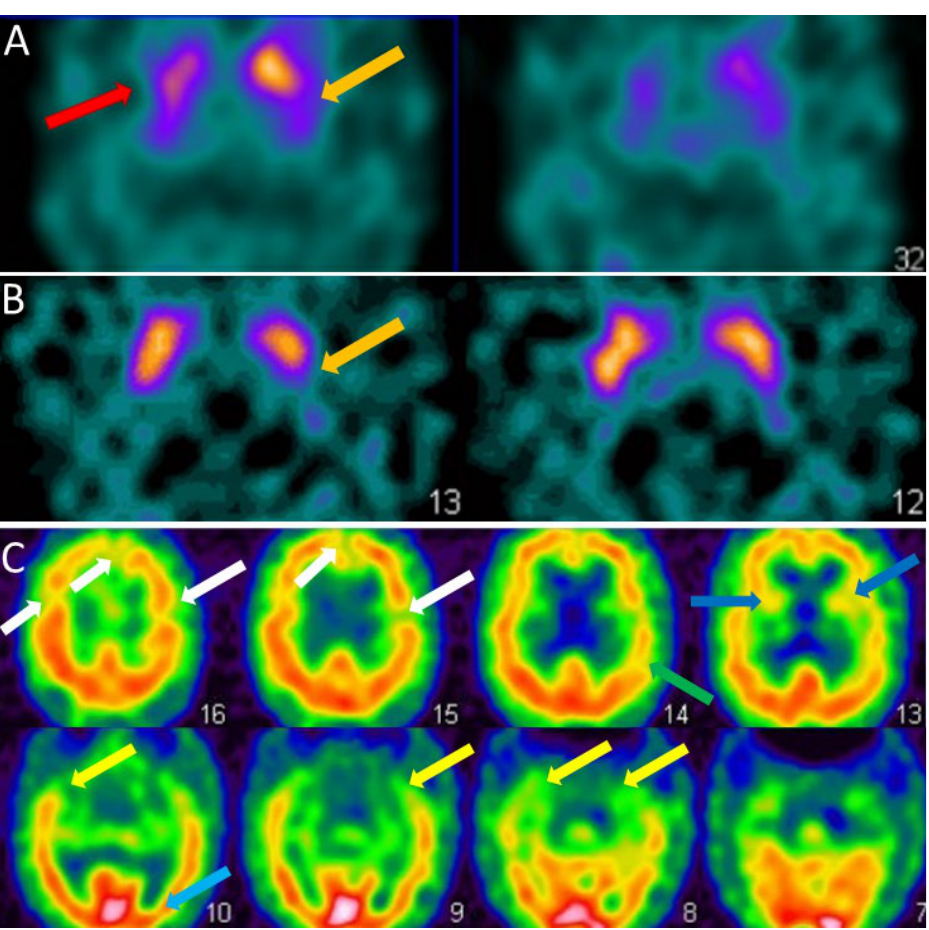
Figure 2. SPECT of patients with dementia with Lewy bodies. ( A ). Brain FP-CIT SPECT (DAT-scan) of a DLB patient of 81 years with mild dementia, cognitive fluctuations, and Capgras syndrome. Axial section FP-CIT SPECT shows lower right striatal, i.e., caudate and putamen, uptake (red arrow) and lower left putamen uptake (orange arrow). ( B ). Brain FP-CIT SPECT (DAT-scan) of a prodromal DLB patient of 74 years with mild cognitive impairment, cognitive fluctuations, and subtle Parkinsonism (UPDRS scale: rigidity 1/4, akinesia 1/4, no tremor). Axial section FP-CIT SPECT shows lower left putamen uptake (orange arrow). ( C ). Brain perfusion SPECT (neurolite) of the same prodromal DLB patient of 74 years with mild cognitive impairment, cognitive fluctuations, and subtle Parkinsonism (UPDRS scale: rigidity 1/4, akinesia 1/4, no tremor). Axial section perfusion SPECT showing a mity aspect with diffuse hypoperfusion involving frontal (white arrows), insular (dark blue arrows), parietal (green arrow), temporal (yellow arrow) and occipital lobes (subtle, light blue arrow).